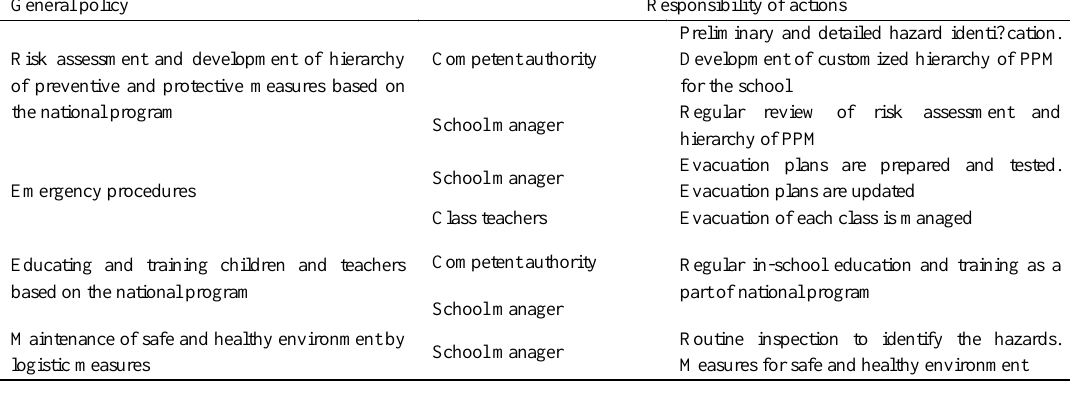
Eliminate the hazard/risk Control the hazard/risk at source